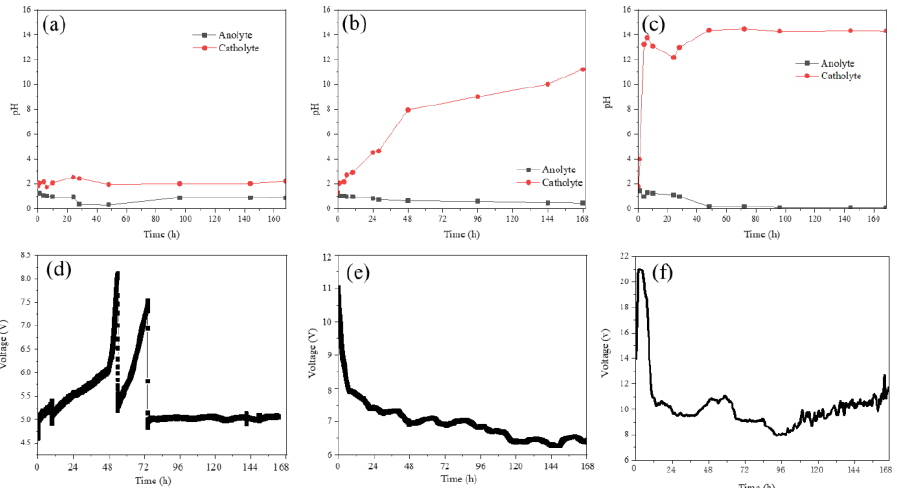
Figure 4. pH changes in anolyte and catholyte of 15 mA ( a ), 35 mA ( b ) and 50 mA ( c ) and voltage variation of 15 mA ( d ), 35 mA ( e ) and 50 mA ( f ).